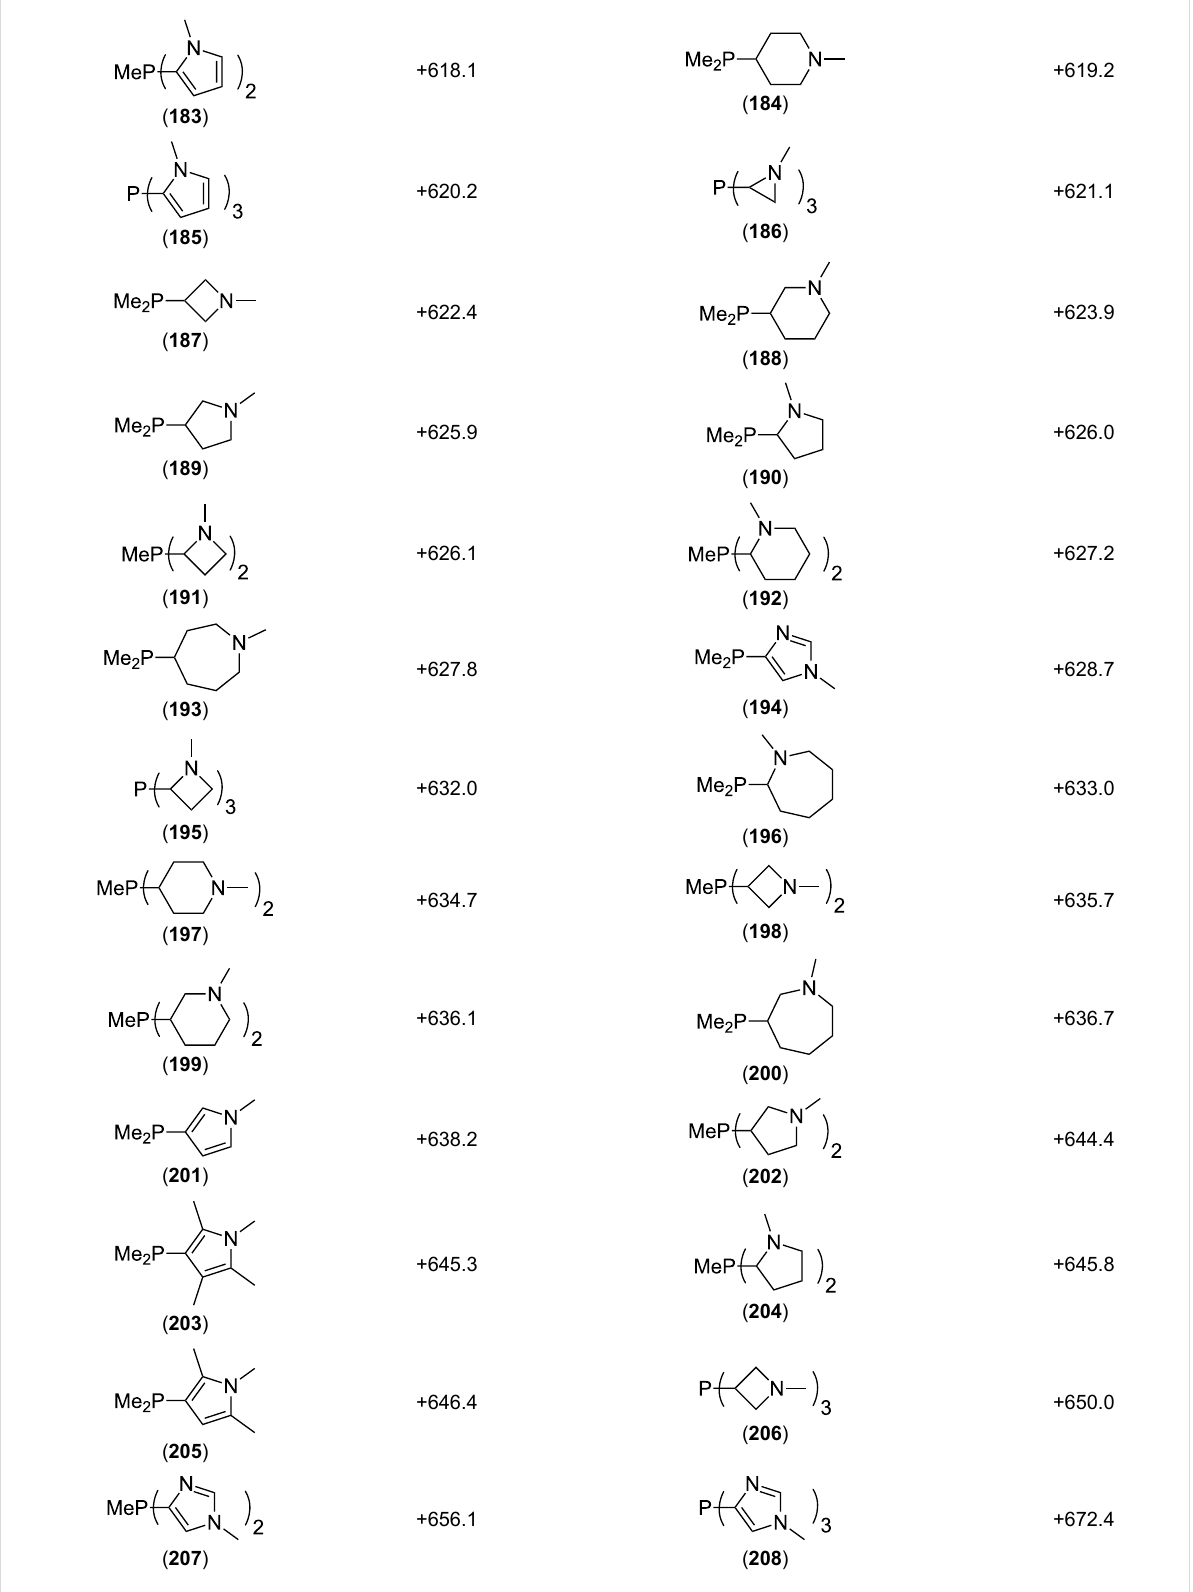
Table 4: MCA values of phosphanes with nitrogen-containing substituents lacking direct phosphorous–nitrogen bonds.